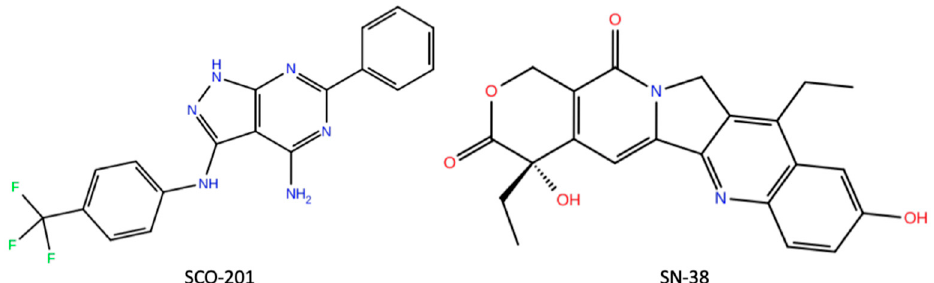
Figure 1. Chemical structures of the pyrazolo[3,4-d]pyrimidine derivative SCO-201 and the active metabolite of irinotecan, SN-38. Graphics produced using Maestro, Schrödinger 2019-3, limited liability company (LLC), New York, NY, 2019. SN-38 structure obtained from PubChem Database [35,36].